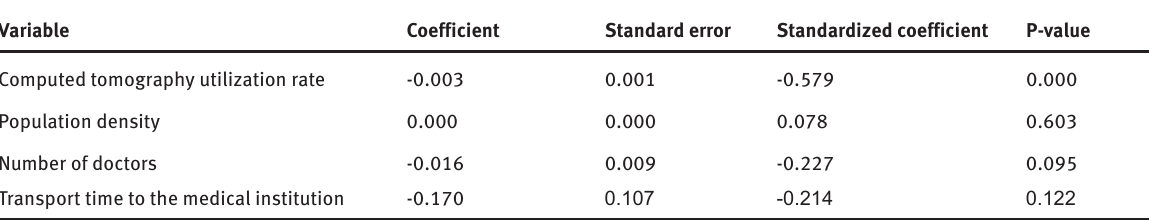
Table 4: Relationship between mortality from accidents and CT utilization